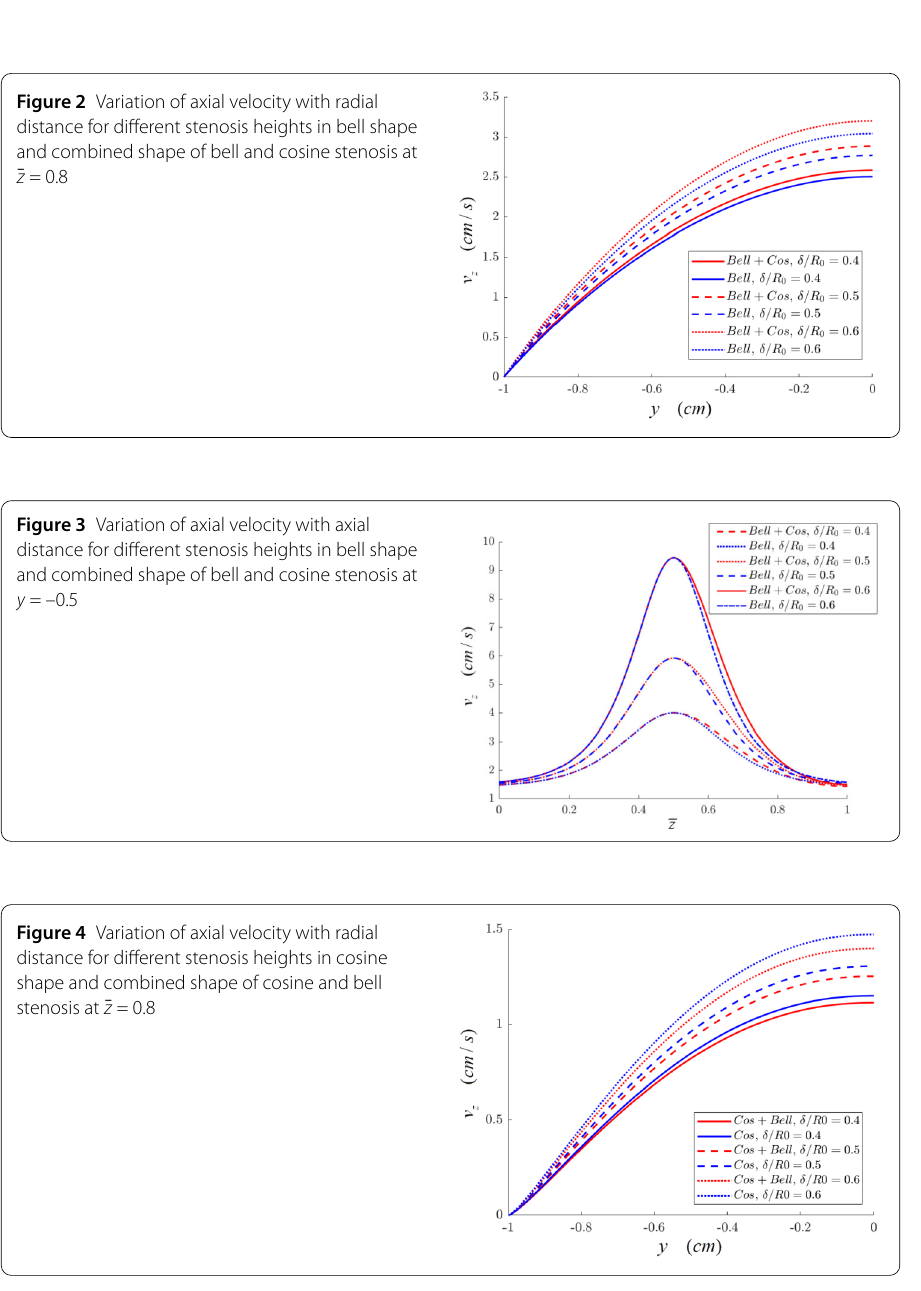
Figure 2 Variation of axial velocity with radial distance for different stenosis heights in bell shape and combined shape of bell and cosine stenosis at ¯ z = 0.8